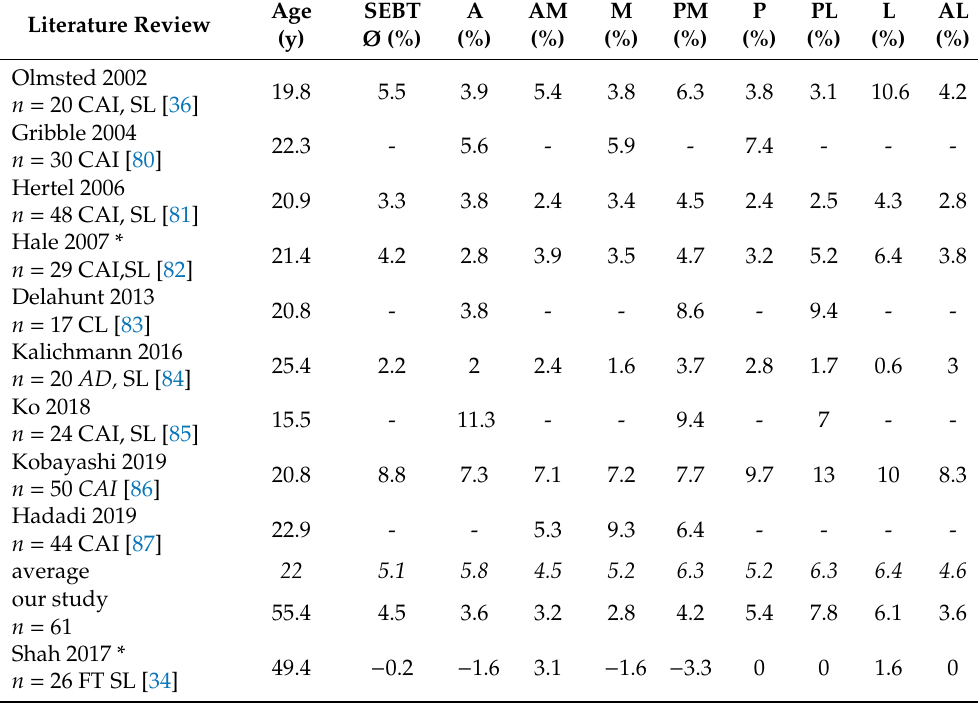
Table 3. SEBT literature comparison, percentage di ff erences between a ff ected leg and control group; SEBT = overall percentage di ff erence, mean value; A, AM, M PM, P, PL, L, AL = di ff erences percentages for each reach direction, mean value; CAI = chronic ankle instability; AD = ankle distortion; CL = cruciate ligament surgery (Lig. cruciforme anterior); FT = fibula transplantation SL = “Split Leg” (comparison between legs of the same